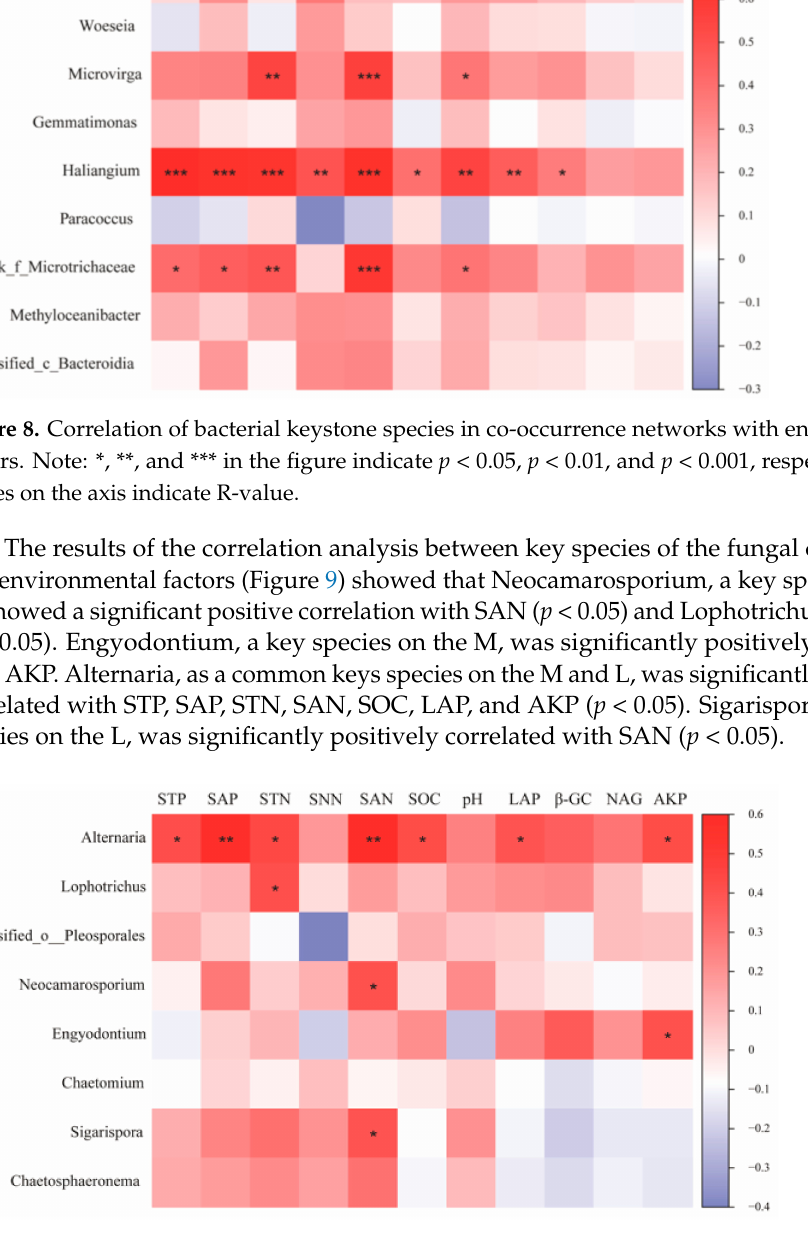
Figure 9. Correlation of fungal keystone species with environmental factors in co-occurrence net- works. Note: * and ** in the figure indicate p < 0.05 and p <